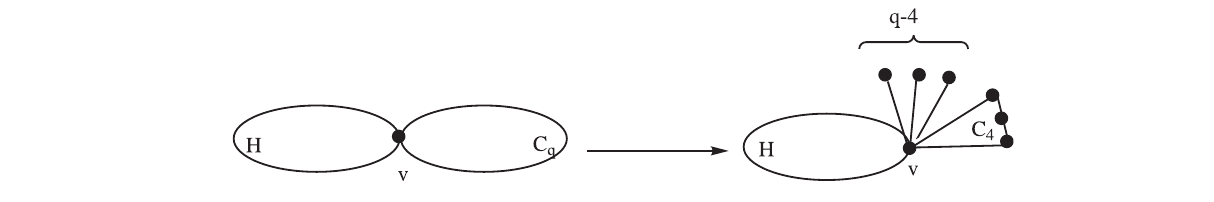
FIGURE 4 | Graphs G 1 and G 2 of Lemma